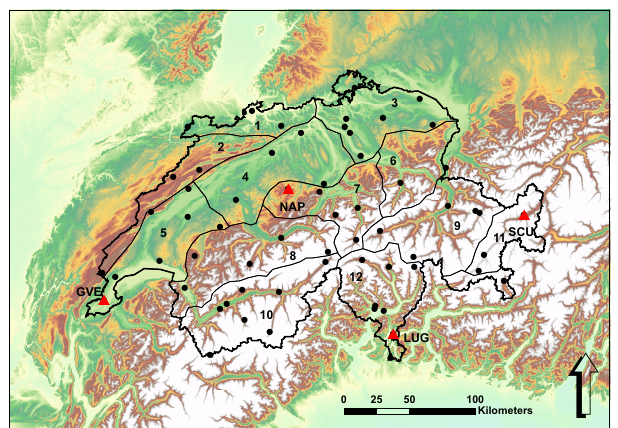
Fig. 1. The SwissMetNet stations in 12 climatic regions defined by Schüepp and Gensler (1980). The four selected stations in this paper are marked by red triangles: GVE – Geneve-Cointrin, NAP – Napf, SCU – Scuol, LUG – Lugano.